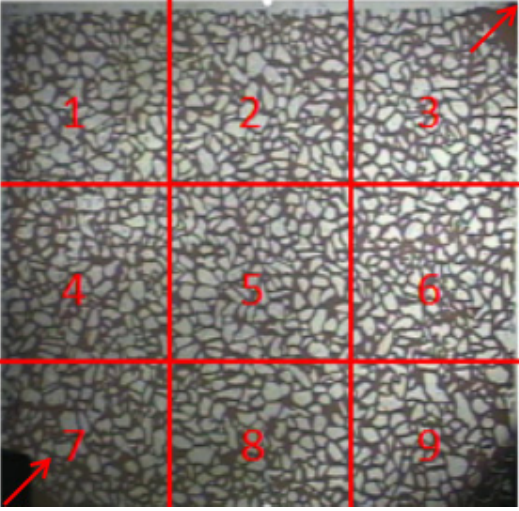
Figure 11. Regional division of the microscopic visualisation